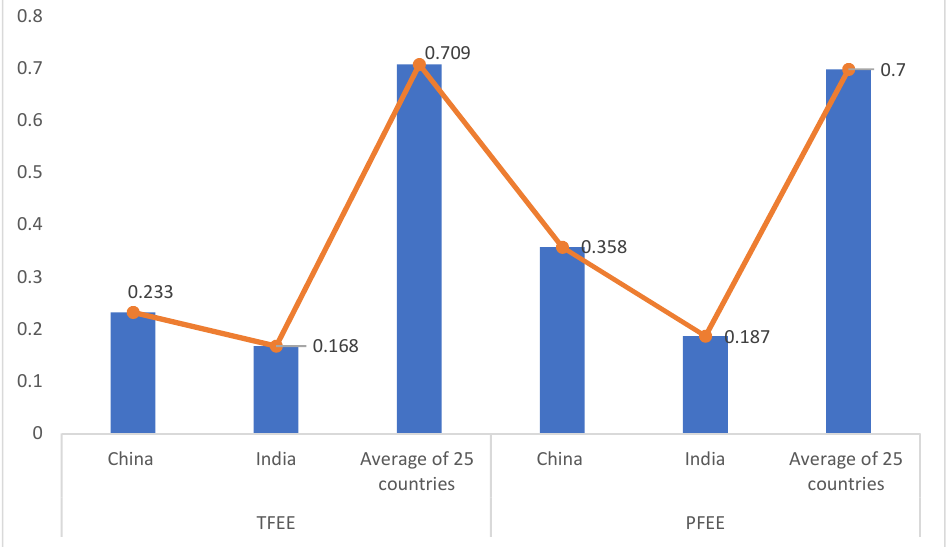
ffi ciency score of China and India vs. the average score of the 25 Figure 2 . Energy efficiency score of China and India vs. the average score of the 25 countries. Figure 2. Energy e